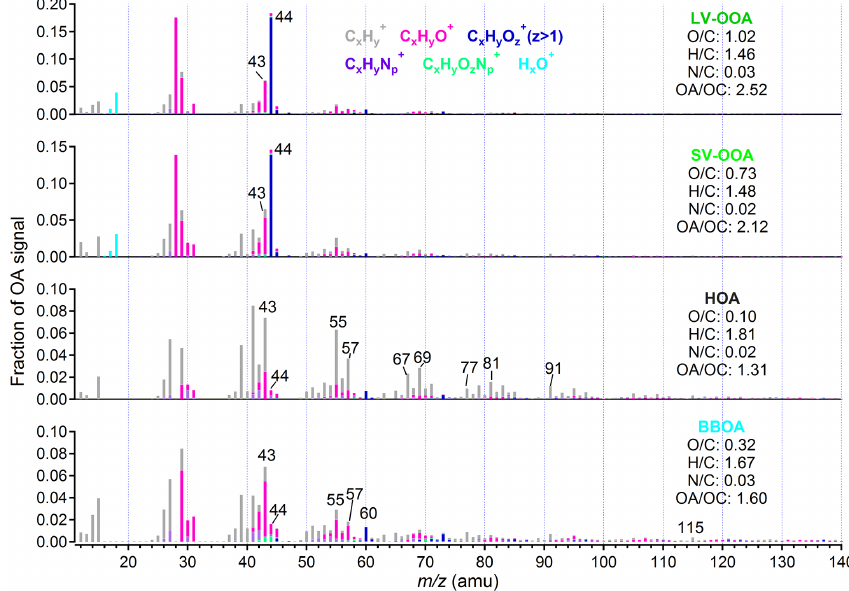
Figure 5. Unit mass spectra of OA factors: LV-OOA, SV-OOA, HOA and BBOA. The elemental ratios and OA / OC ratios of each component are also added.